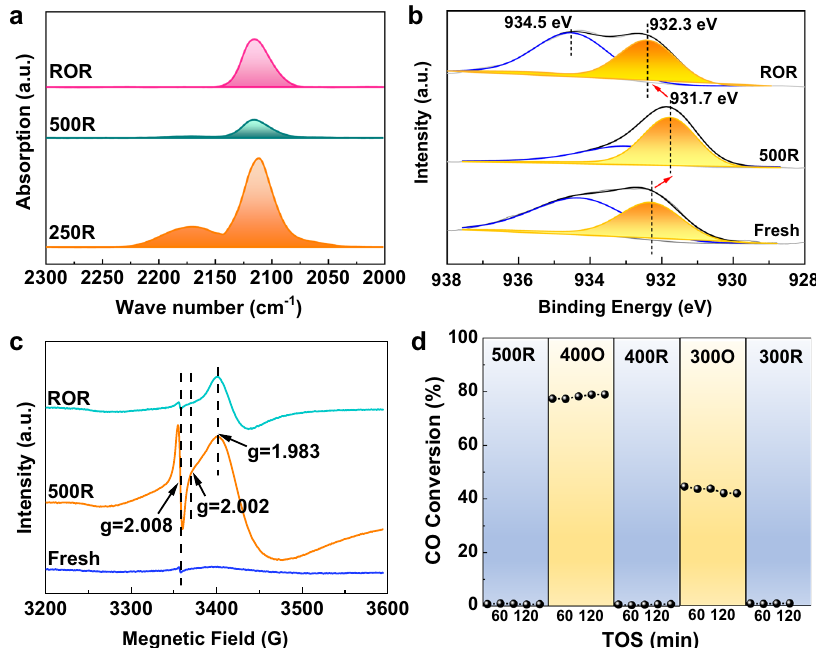
Fig. 3 Identi fi cation of classical SMSI over SP-Cu/LaTiO 2 catalyst. a CO-IR spectra of fresh SP-Cu/LaTiO 2 sample with a successive reduction and oxidation treatments: reduced at 250°C (-250R), further reduced at 500 °C (-500R), then oxidized at 400 °C and again reduced at 250 °C (-ROR). b , c Quasi in-situ XPS of Cu 2 p ( b ) and EPR spectra ( c ) of SP-Cu/LaTiO 2 -fresh, SP-Cu/LaTiO 2 -500R and SP-Cu/LaTiO 2 -ROR samples. d Reversibility of catalytic performance over CO + NO reaction after redox pretreatments. CO conversions in CO + NO reaction were collected at 250 °C. Before each reaction cycle, samples were pretreated with 99.99% H 2 (XR) or 5% O 2 /He (XO) at different temperatures for 1 h, where X represents the